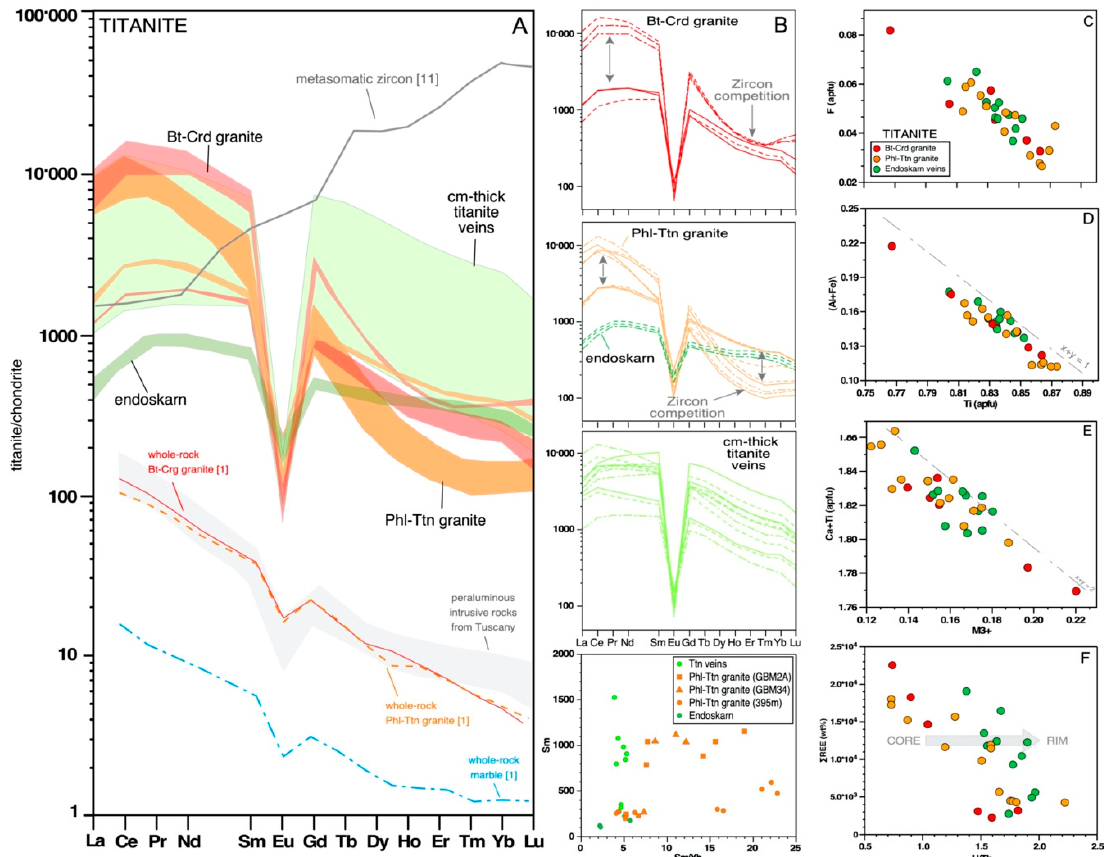
Figure 8. ( A ) Chondrite-normalized REE patterns for titanite from the biotite granite, the phlogopite- titanite granite and the endoskarn. On the right ( B ) detailed chondrite-normalized REE patterns for titanite from each lithology are reported. ( C – F ) Compositional diagrams of metasomatic titanite from various lithologic types. For comparison, whole-rock (WR) data are taken from reference [1]. Chondrite normalization values are taken from reference